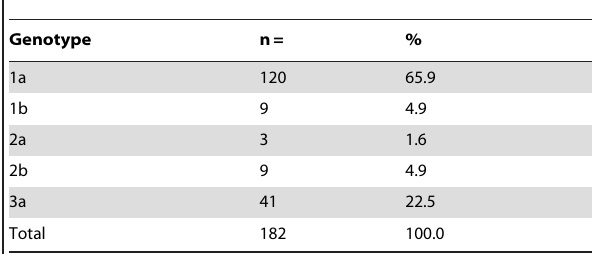
Table 2. HCV genotype distribution.